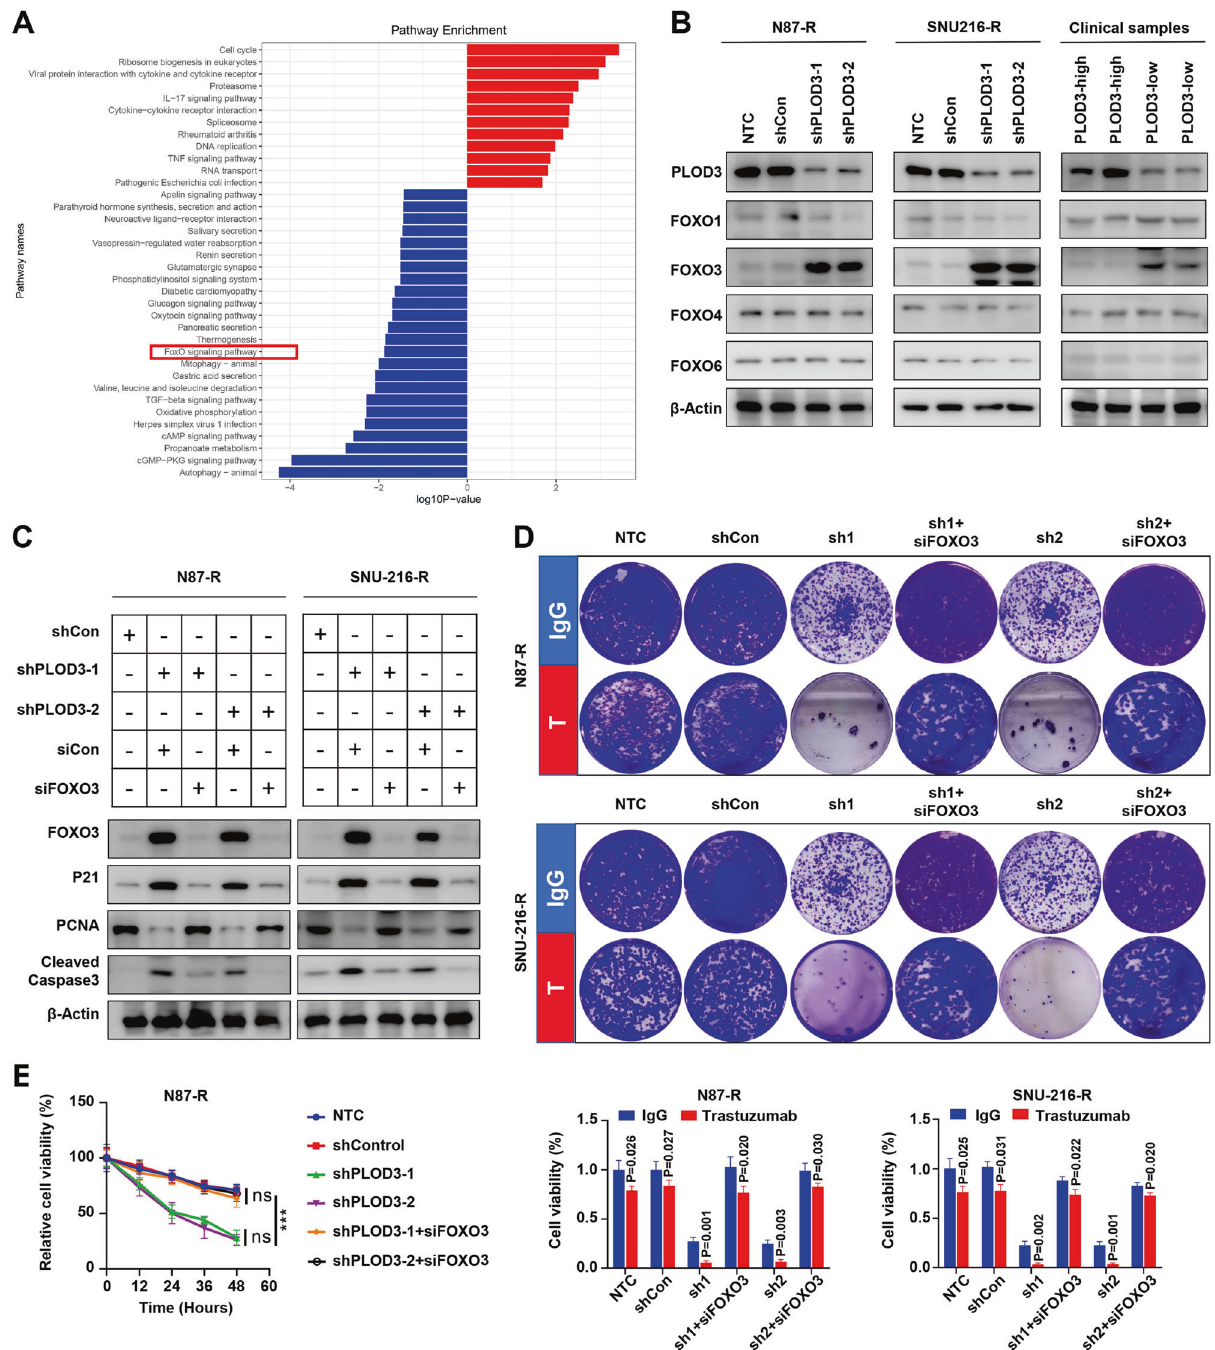
Fig. 6 PLOD3 decreased protein stability of FOXO3 to promote Trastuzumab resistance in GC. A KEGG analysis was performed to investigate signi fi cantly altered signaling pathways between PLOD3-high and PLOD3-low subgroup in GC according to TCGA database. B FOXO3 showed dramatically increased expression after PLOD3-KD according to western blot. C FOXO3 silencing could effectively rescue the inhibitory effects of PLOD3 knockdown on p21 and cleaved caspase3 expressions under Trastuzumab treatment. D Silencing FOXO3 could restore Trastuzumab resistance in PLOD3 knockdown GC cells according to colony formation assays. E FOXO3 depletion reversed the cell proliferation inhibition of PLOD3 knockdown in GC cells under Trastuzumab treatment according to MTT assays. F , G The protein stability of FOXO3 after PLOD3 knockdown in N87R and SNU-216R cells were conducted by CHX pulse-chase experiments. H , I PLOD3 knockdown affected FOXO3 ’ s ubiquitination level according to ubiquitination antibody ratio and membrane permeability. Compared to trastuzumab deruxtecan has signi fi cantly improved the response trastuzamab, pertuzumab targets HER-2 receptor protein epitopes rate (51% vs. 14%) and overall survival (12.5 vs. 8.4 months) of differently and has shown considerable improvement in survival HER-2 positive advanced gastric cancer patients compared with rates.Combined with trastuzumab chemotherapy, pertuzumab chemotherapyr [11], indicating that trastuzumab deruxtecan may has shown to signi fi cantly improve survival outcomes for be less affected by high HER-2 expression due to its high drug-to-